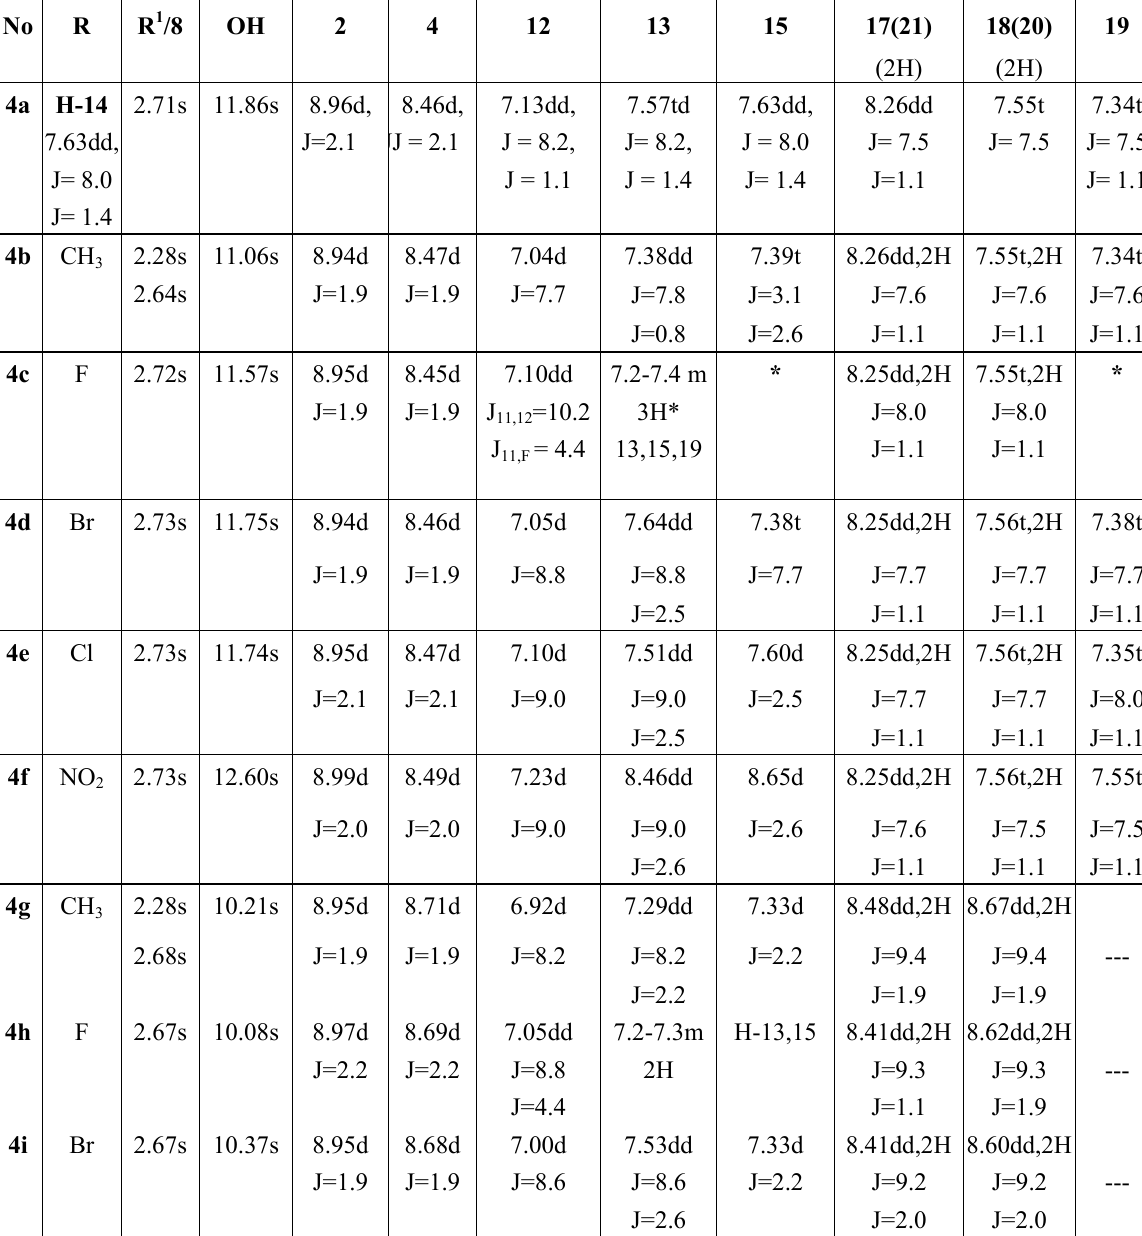
Table 2: 1 H-NMR spectral data of pyrazolo[3,4-b]pyridines